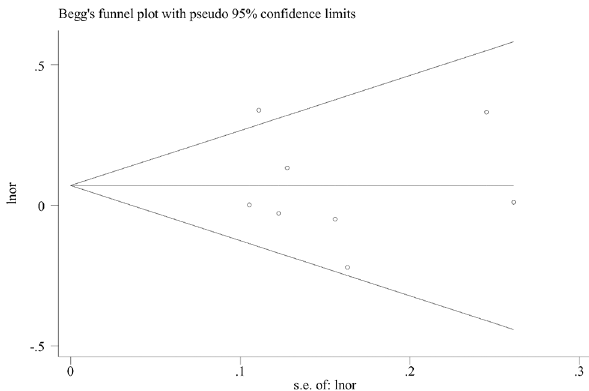
Fig 5. Funnel plot of any prenatal alcohol exposure and overall congenital heart defects